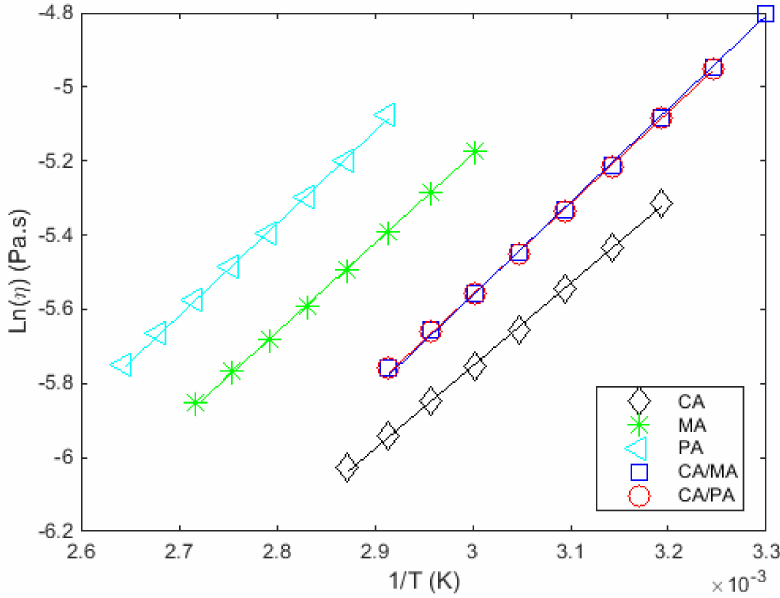
Figure 5. ln ( η ) vs. (1/ T ) at a constant shear rate (100 s − 1 ) for the studied